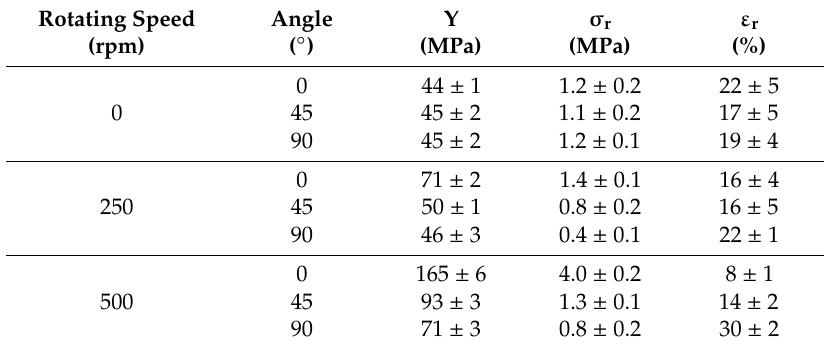
Table 2. Summary of the mechanical properties of the prepared membranes in three different directions.